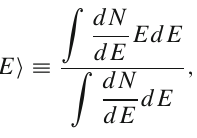
γ L = γ ( E / GeV ) n L , for any value of n . Naively, we 0